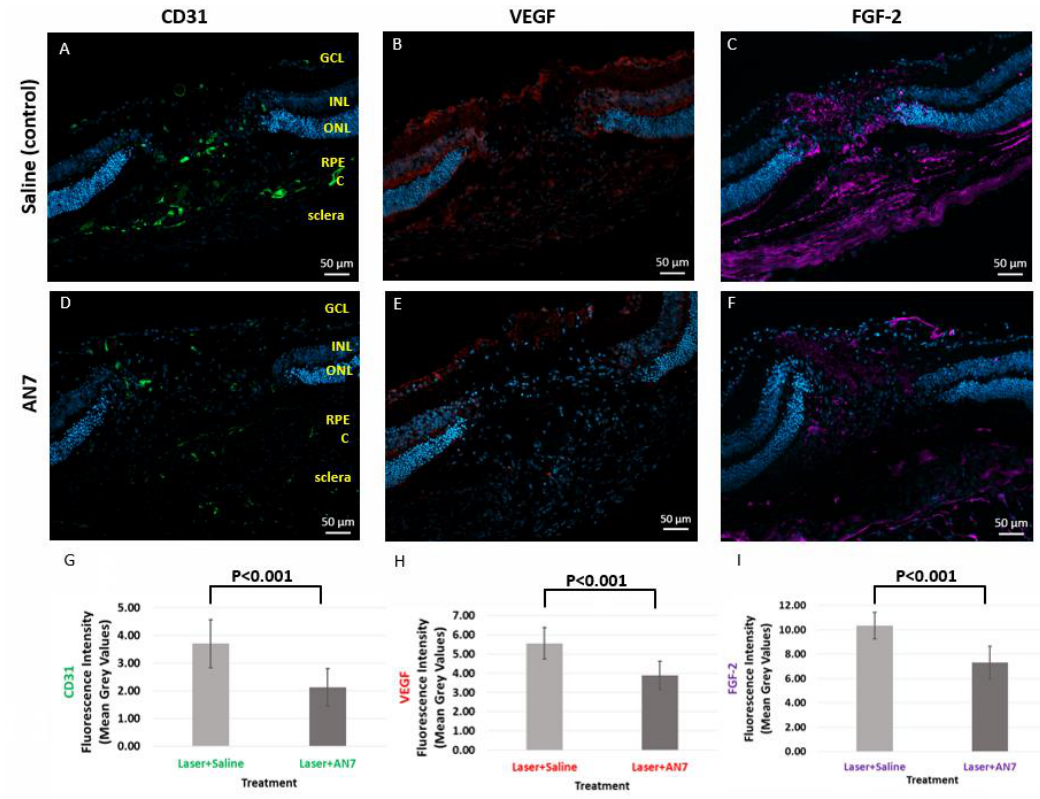
Figure 3. AN7 treatment reduces CD31, vascular endothelial growth factor (VEGF) and fibroblast growth factor 2 (FGF-2). Representative images of laser lesion sites from mice treated with IP 20 mg/kg AN7 or saline (control), from day 3 post laser photocoagulation. Sequential cryosections are stained for endothelial cells marker CD31 (green; A , D ), VEGF (red; B , E ), and FGF-2 (purple; C , F ). Cells nuclei are stained with DAPI (blue). GCL, Ganglion Cells Layer; INL, Inner Nuclear Layer; ONL, Outer Nuclear Layer; RPE, Retinal Pigmented Epithelium; C, Choroid. Scale bar, 50 µ m. ( G ) Quantification of CD31 staining in laser applied eyes. ( H ) Quantification of VEGF staining in laser applied eyes. ( I ) Quantification of FGF-2 staining in laser applied eyes.